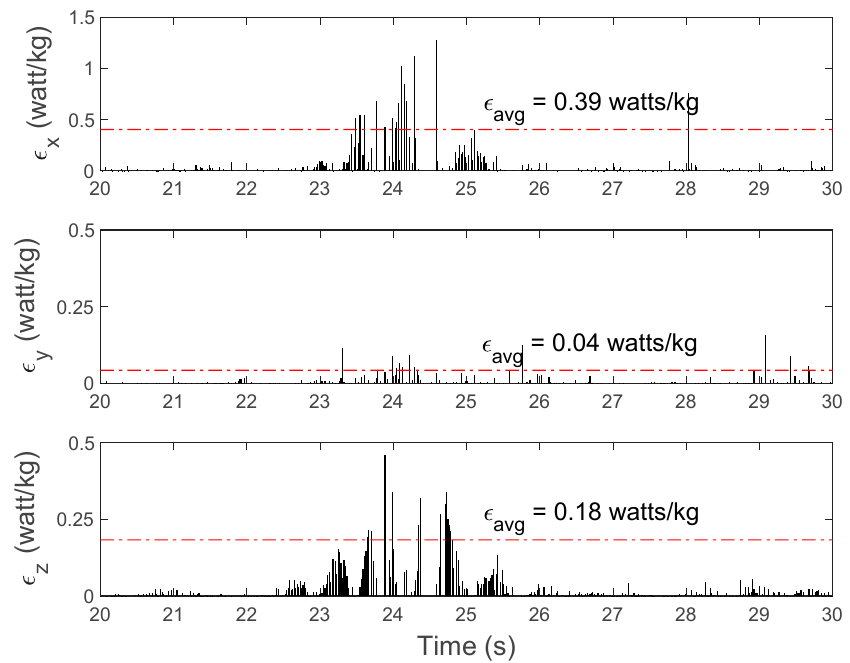
Figure 10. Energy dissipation rate at various times evaluated based on the measured velocities at x = 7 m and 22.5 cm below the free surface. The red dot–dashed lines indicate the averaged energy dissipation rates of the top 30% of the values from 23 to 26 s.